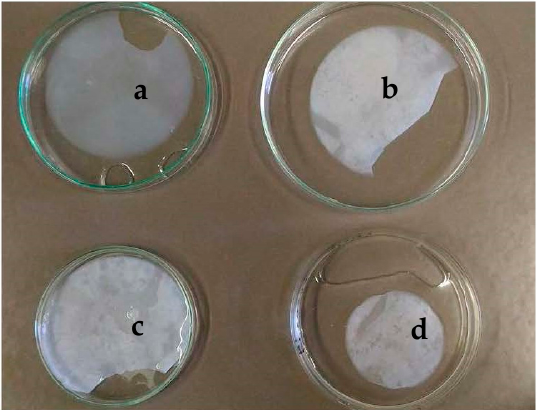
Figure 2. BNC ( a ); BNC-GMA MS = 0.25 ( b ); BNC-GMA-EGDMA MS = 0.8 ( c ); BNC-EGDMA MS =